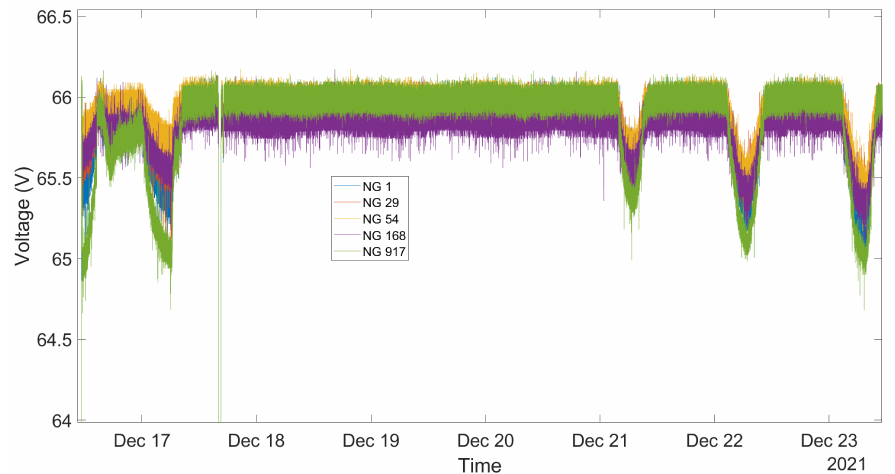
Figure 32. Evolution of the DC bus voltage on Ambohimena